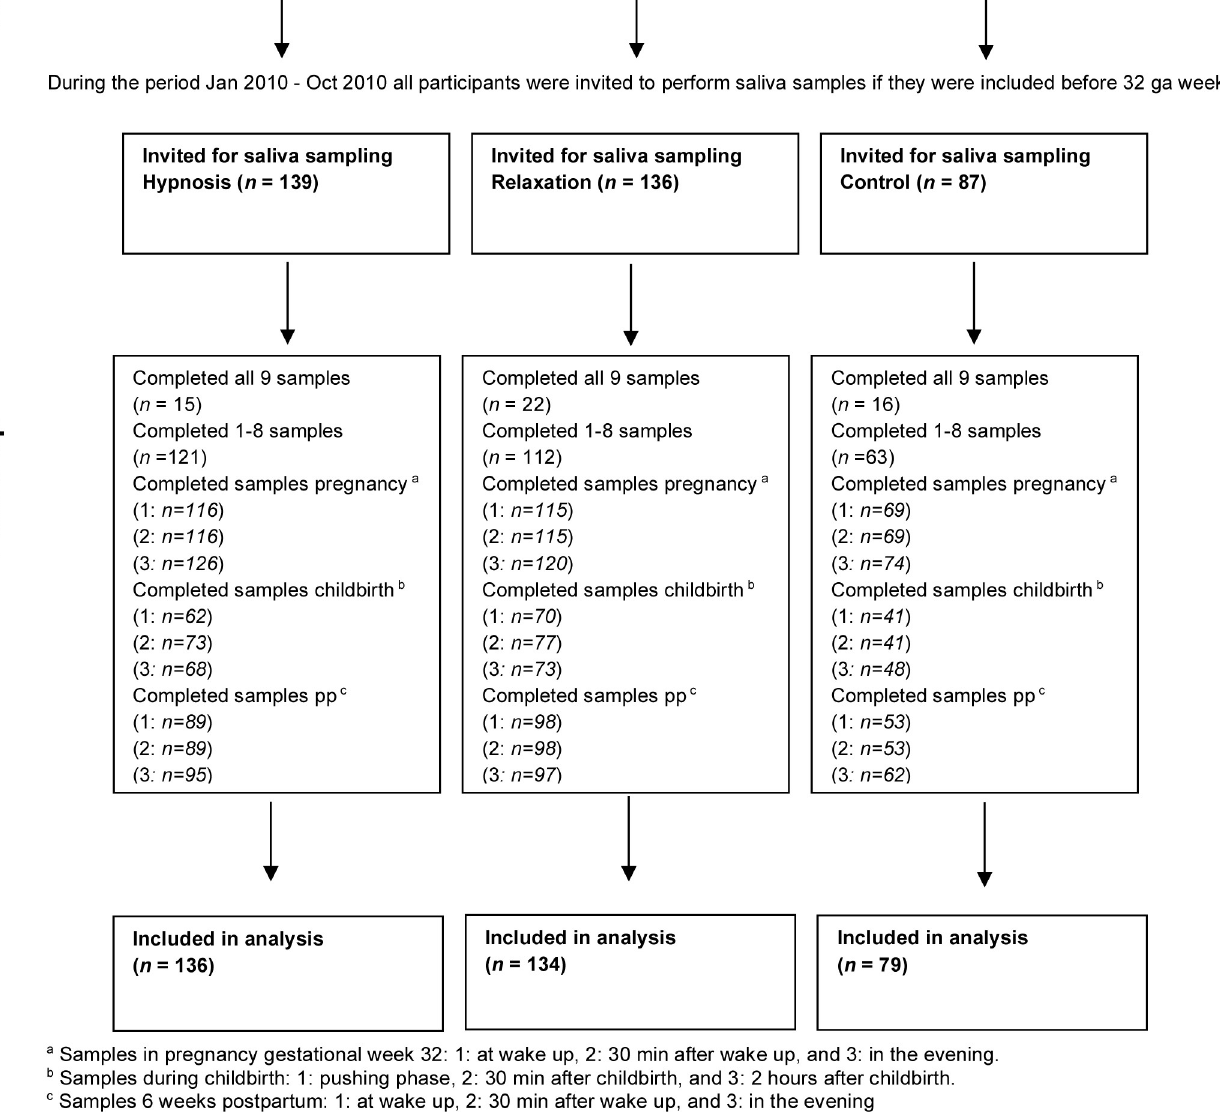
Fig 1. Flow diagram of enrolment, allocation, and study participation.